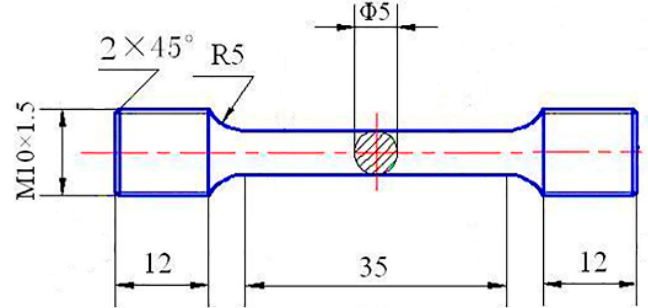
Figure 2. Sample geometry of a tensile specimen (unit: mm). Table 1. Practical chemical composition of the test alloy (wt. %).